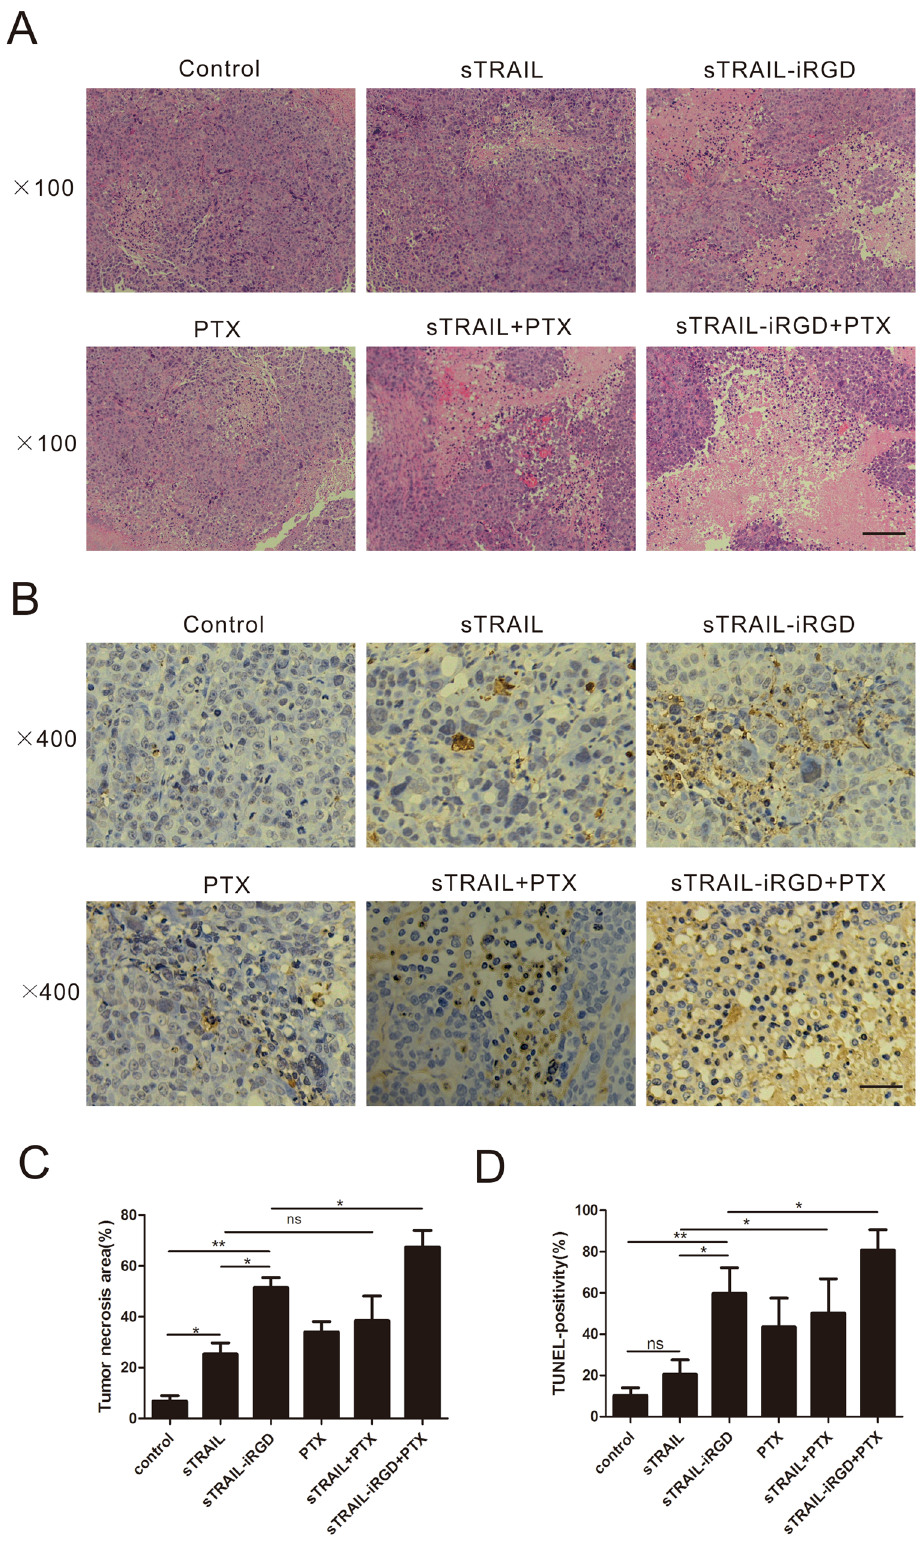
Figure 8. Cell death analysis in sTRAIL-iRGD-treated MKN45 tumors. H&E staining of tumor sections from mice intraperitoneally injected with PBS, sTRAIL, sTRAIL-iRGD, PTX, sTRAIL + PTX or sTRAIL- iRGD + PTX. ( A ) Cell death was evaluated by TUNEL assay. ( B ) Quantification of tumor necrosis area. ( C ) and TUNEL immunohistochemical positivity. ( D ) Error bars denote SD. * p ≤ 0.05; ** p ≤ 0.01; ns, not significant. Scale bar = 100 μ